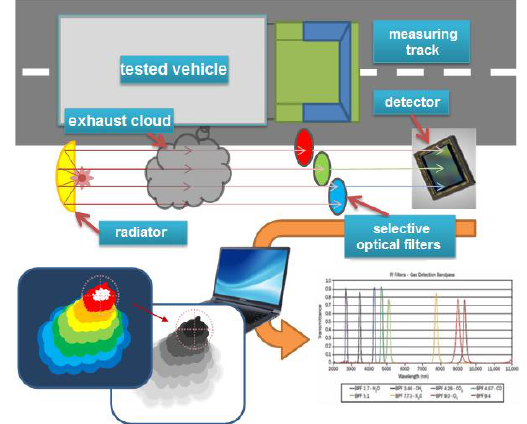
Fig. 8. General diagram of the stand for spectral measurements of exhaust gas composition